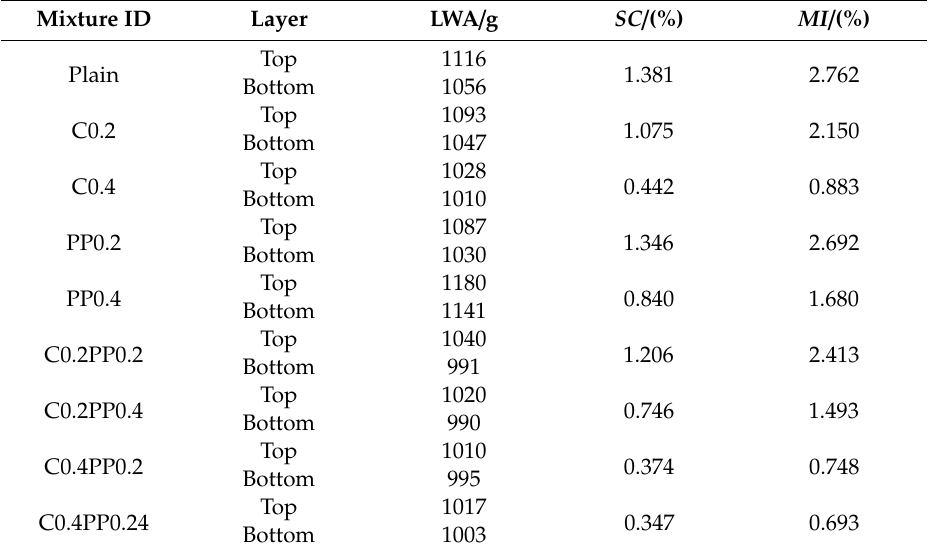
Table 8. Distribution of coarse LWA for LWAC and corresponding segregation